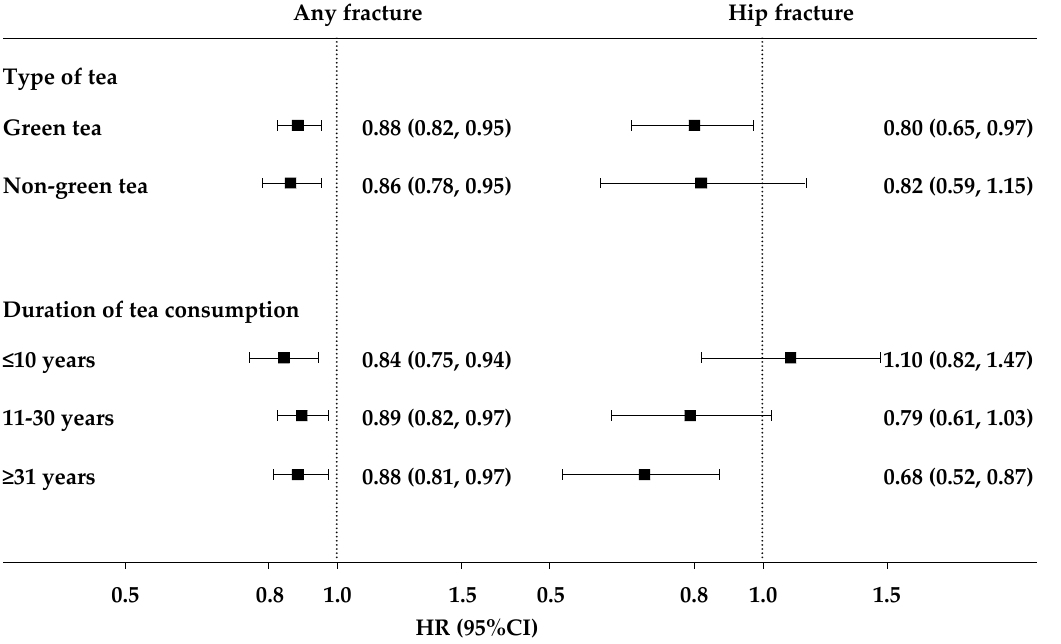
Figure 1. Subgroup analyses of associations between tea consumption and risk of fracture according to types of tea and duration of tea consumption in daily consumers. Hazard ratios are for comparison of daily tea consumers with participants who never consumed tea during the past 12 months. Risk estimates for participants who consumed tea less than daily are shown in Table S3. Solid squares represent point estimates, and horizontal lines represent 95% confidence intervals.